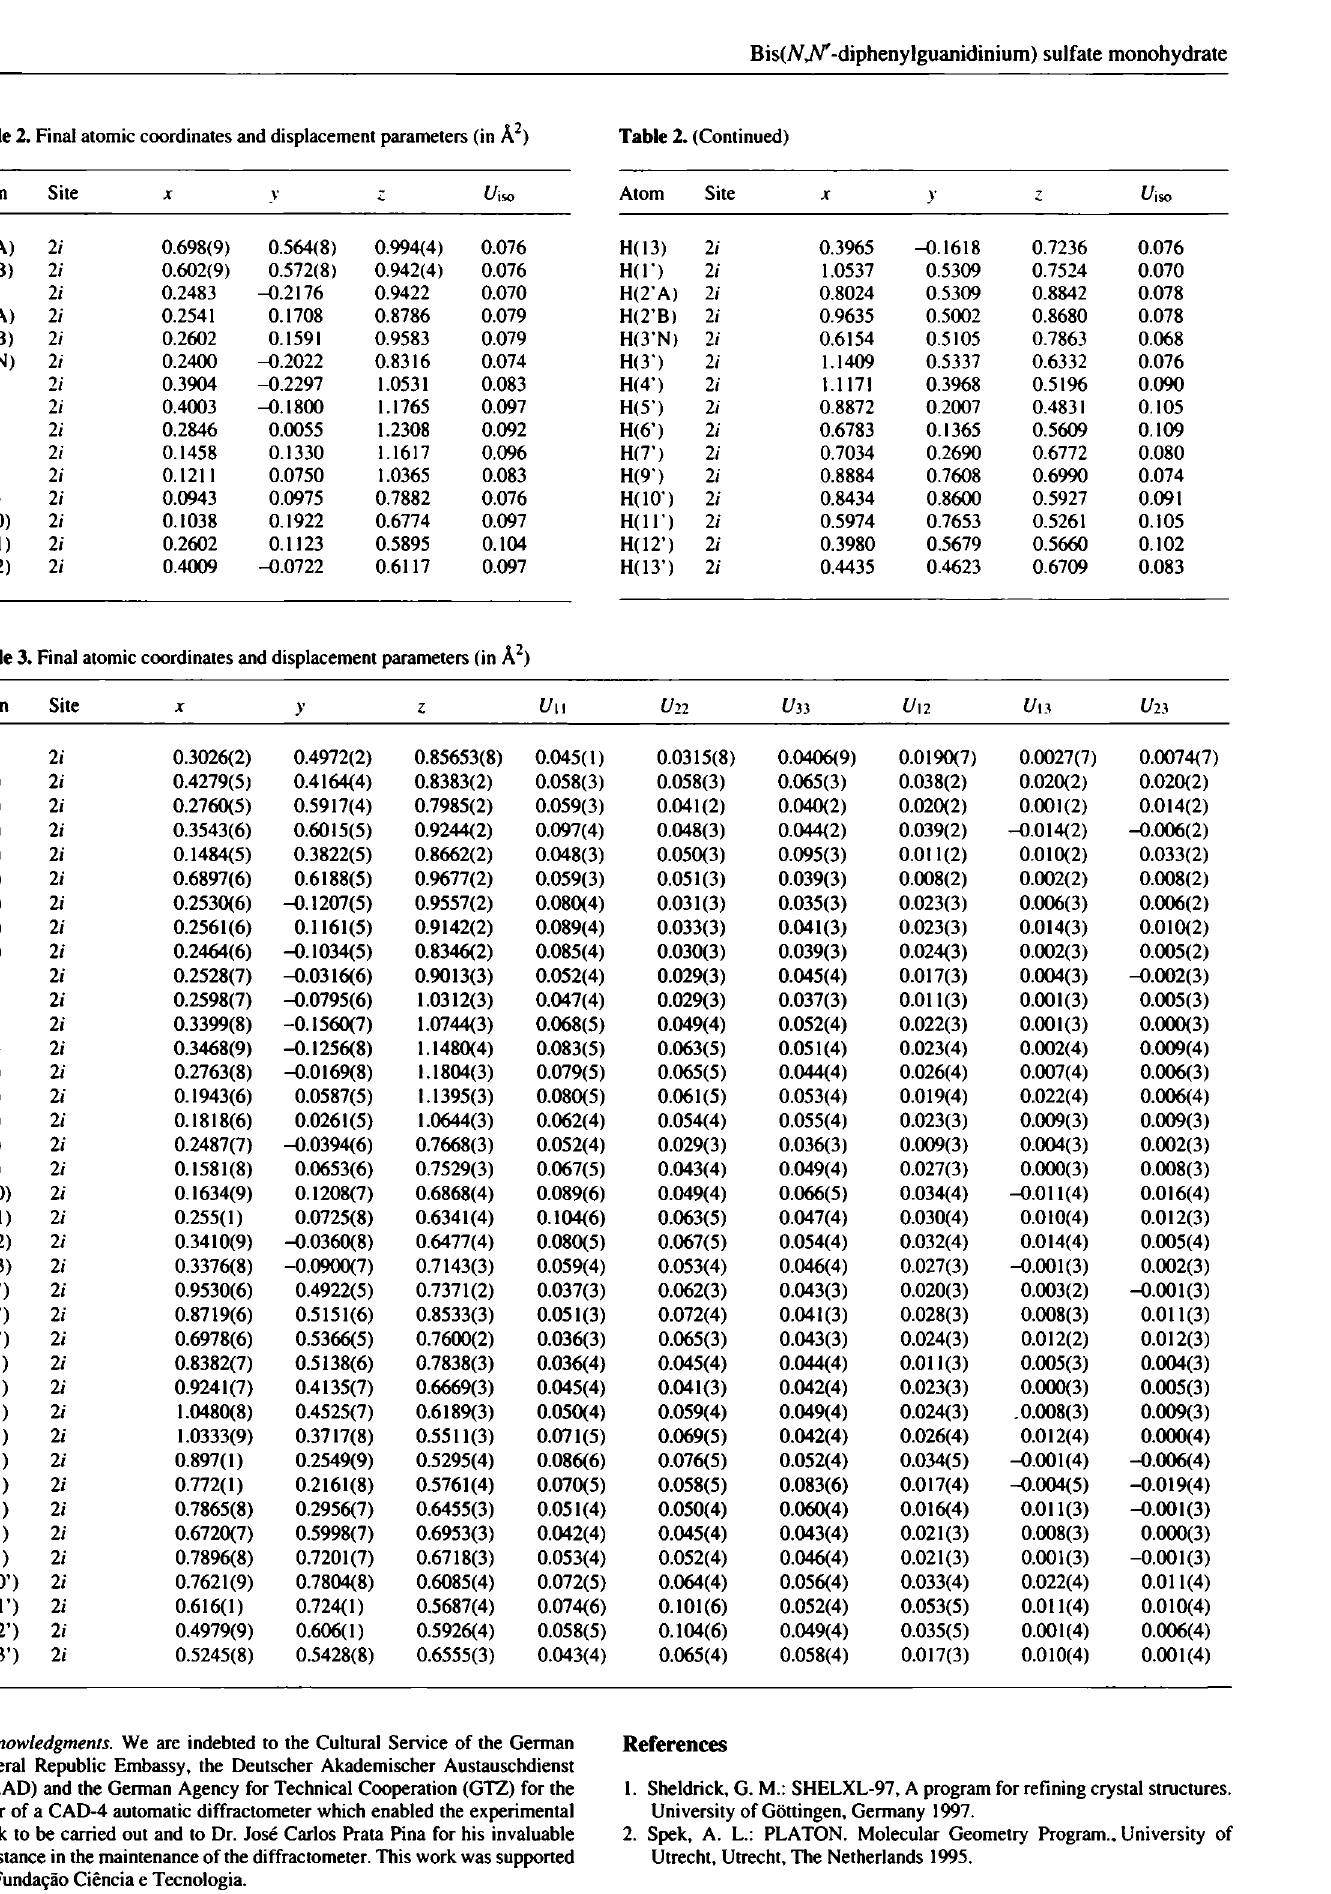
Table 3. Final atomic coordinates and displacement parameters (in